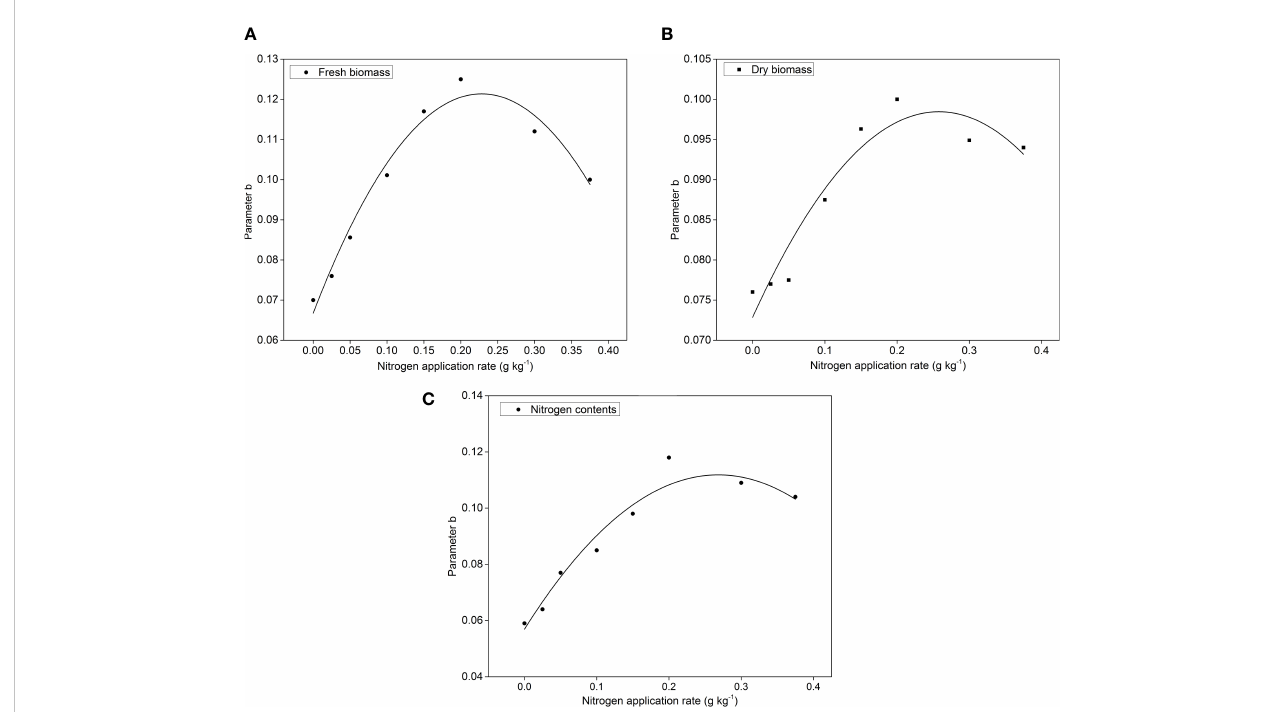
FIGURE 4 The relationship between parameter b and N application rate for (A) FW, (B) Dry DW and (C) Nitrogen contents in pakxhoi with the following formula N c ( % )= a ×DW − b .